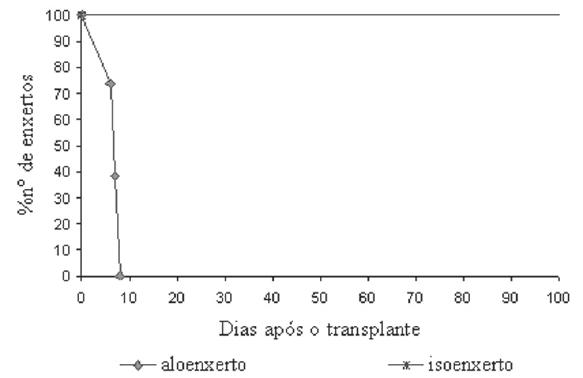
Fig. 4 – Gráfico de sobrevida dos enxertos cutâneos: 30 isotransplantes e 34 alotransplantes